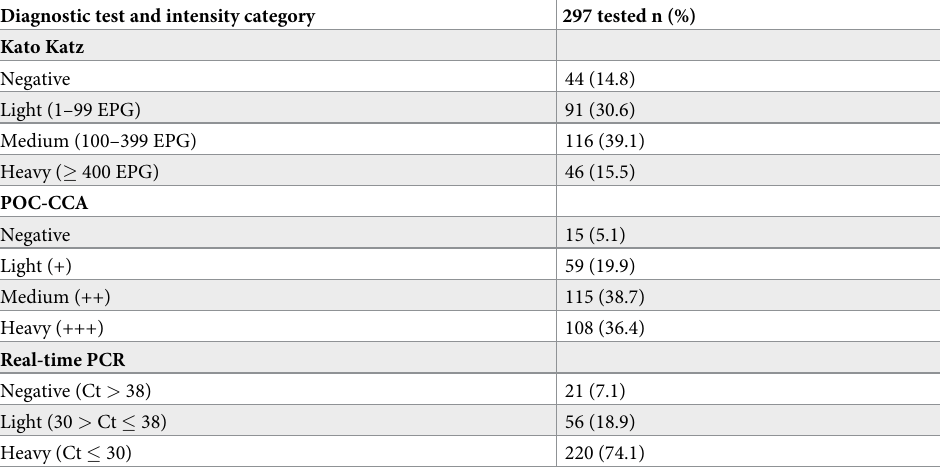
Table 2. Intensity of infection categories for S . mansoni by each examined diagnostic